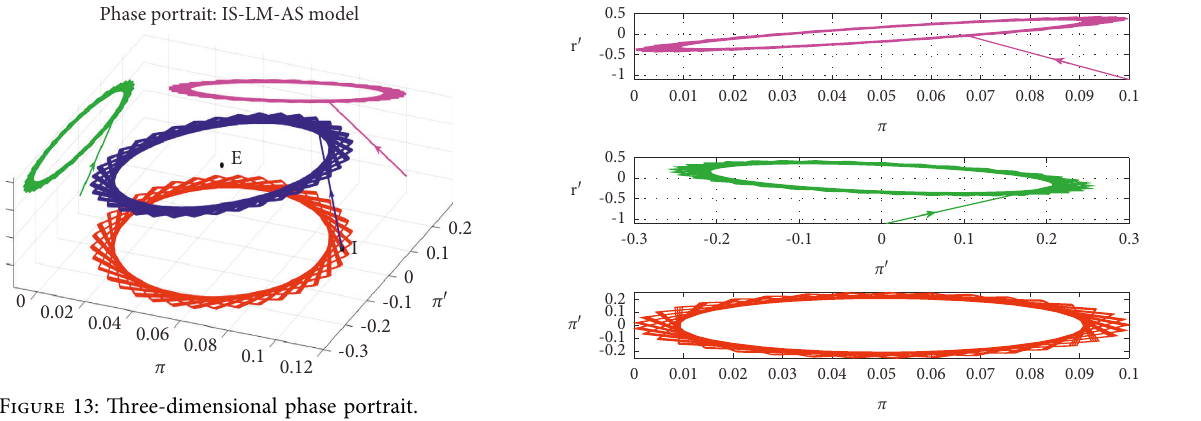
Figure 14: Projections at R 2 of the three-dimensional phase